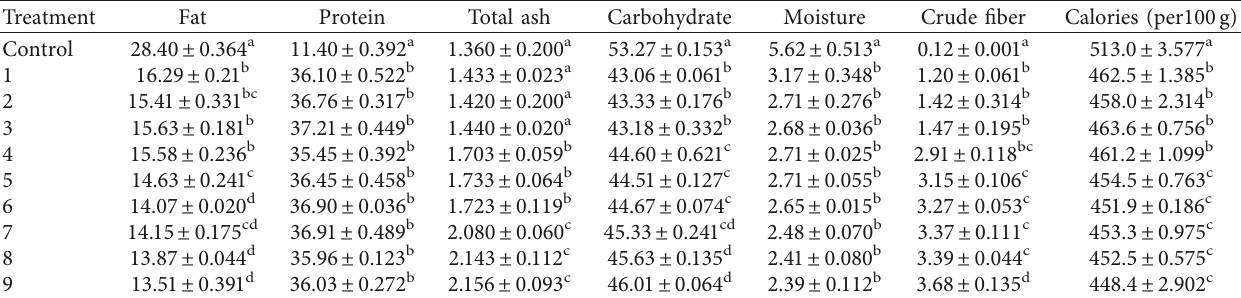
Table 4: Approximate values of nutritional and chemical properties of cakepremix powders (%). Treatment Fat Protein Total